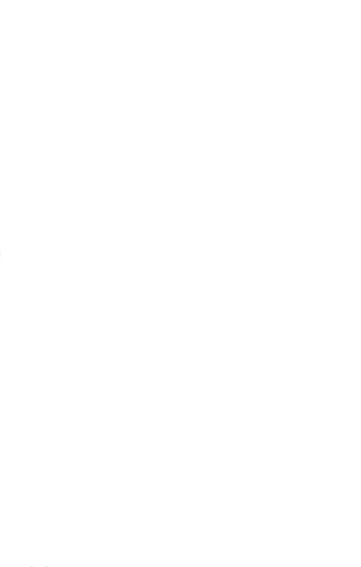
Fig 1. Proposed structural model of ICSR Q. Note. Adapted from